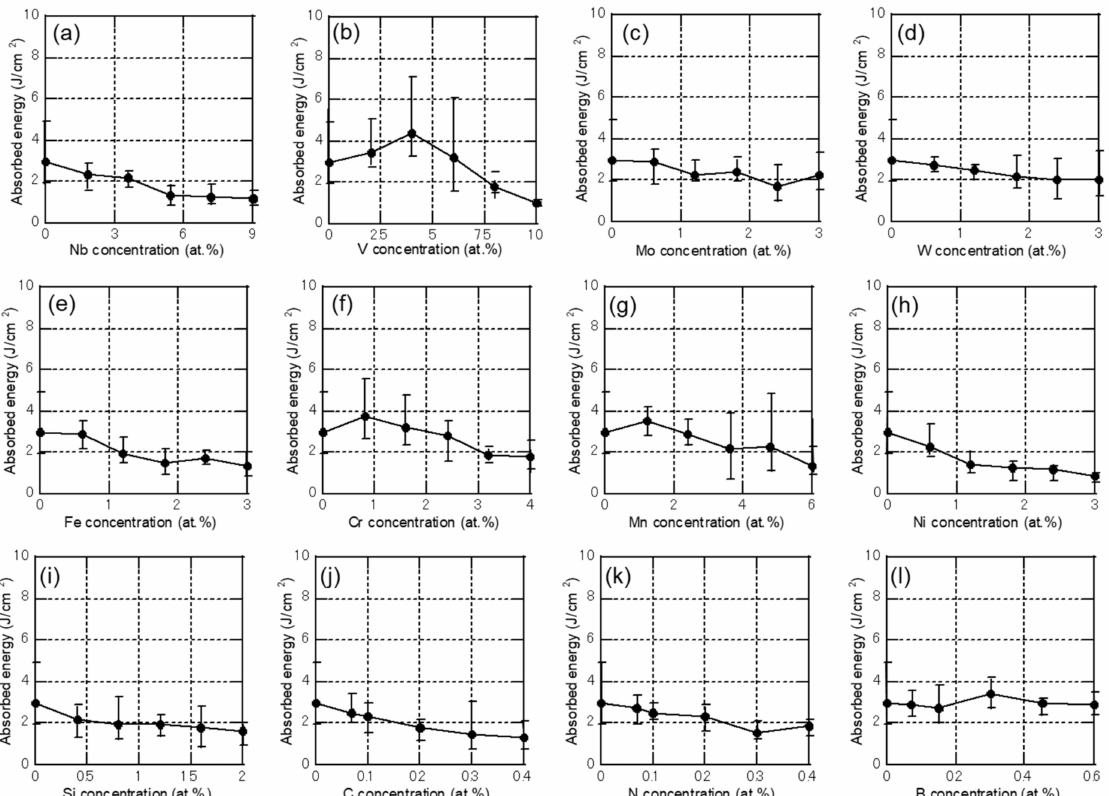
Figure 5. Charpy absorbed energies of the Ti-Al-X ternary alloys after heat treatment at 1200 ◦ C for 4 h, followed by cooling at 10 ◦ C/min: ( a ) Nb; ( b ) V; ( c ) Mo; ( d ) W; ( e ) Fe; ( f ) Cr; ( g ) Mn; ( h ) Ni; ( i ) Si; ( j ) C; ( k ) N; and ( l )